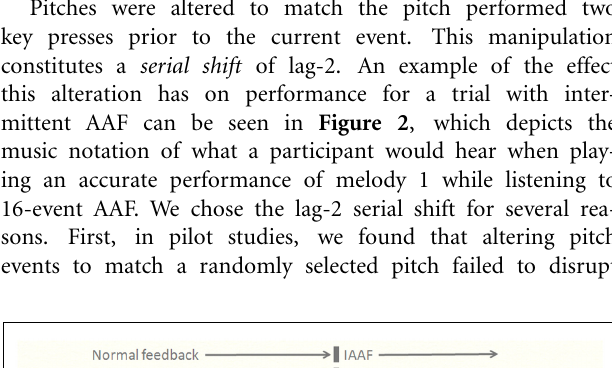
Iteration refers to a single repetition of the eight-note melody.Thus, altered events can fall in one of the four iterations that contain the 32 notes of the performance eligible for alteration. “Repeat altered positions” refers to the number of positions in the sequence that are altered in at least two parameter files.